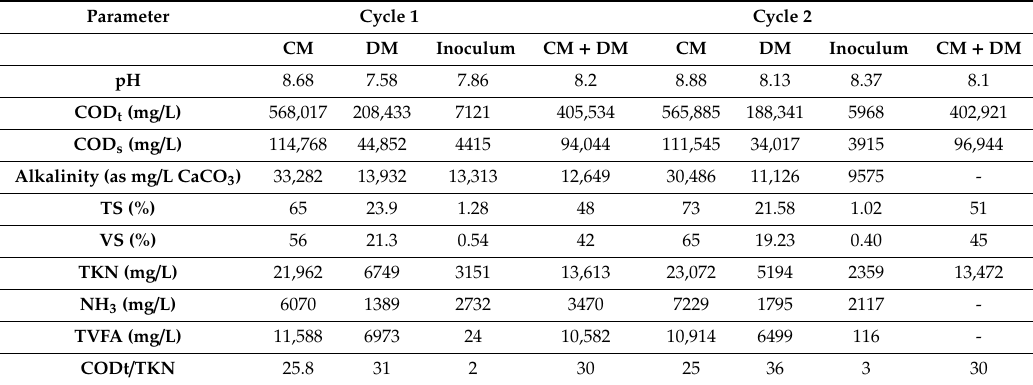
Table 3. Characteristics of feedstock and